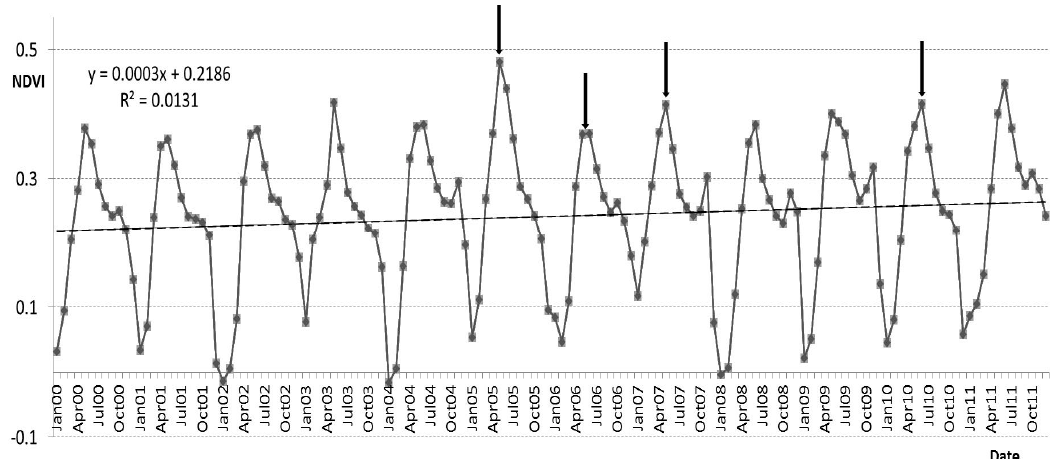
Figure 3. Seasonal Normalized Difference Vegetation Index (NDVI) profile for shrublands in the study area (aggregated from 3357 shrubland plots and field data). Arrows denote years that had large burned area relative to other years. The trend line indicates that greenness in these shrublands trended upward over the time frame.